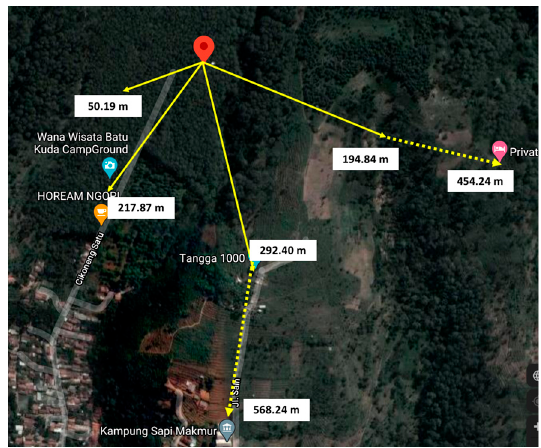
Figure 14. Non - LoS Tracking Scenario at Suburb Forest Batu Kuda Manglayang. Figure 14. Non-LoS Tracking Scenario at Suburb Forest Batu Kuda